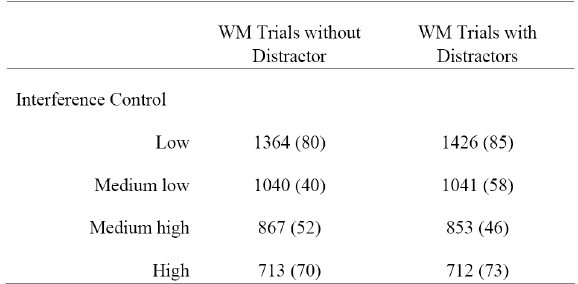
Table 2: Group comparisions of the mean reaction times (in msec; standard deviations in parenthesis) in the incongruent trials of the interference control task as a function of experimental condition